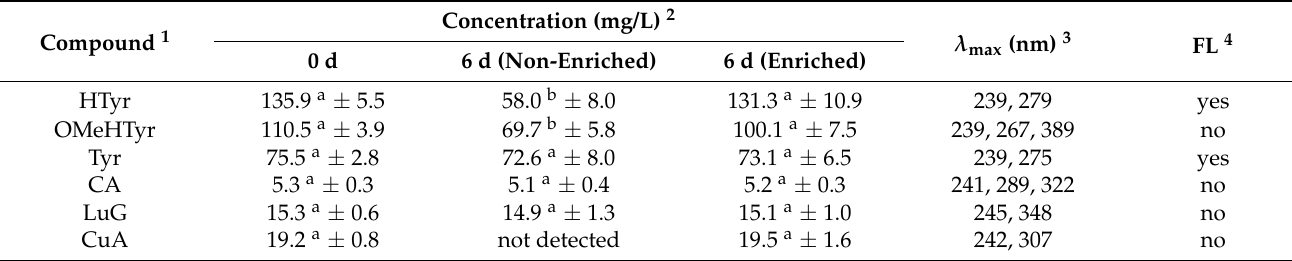
Table 5. Content of individual phenolic/secoiridoid compounds in non-sterile lye (non-enriched or nutrient-enriched) prior and after fermentation at the maximum β -carotene production by B. trispora (fermentation time: 6 days). Compound